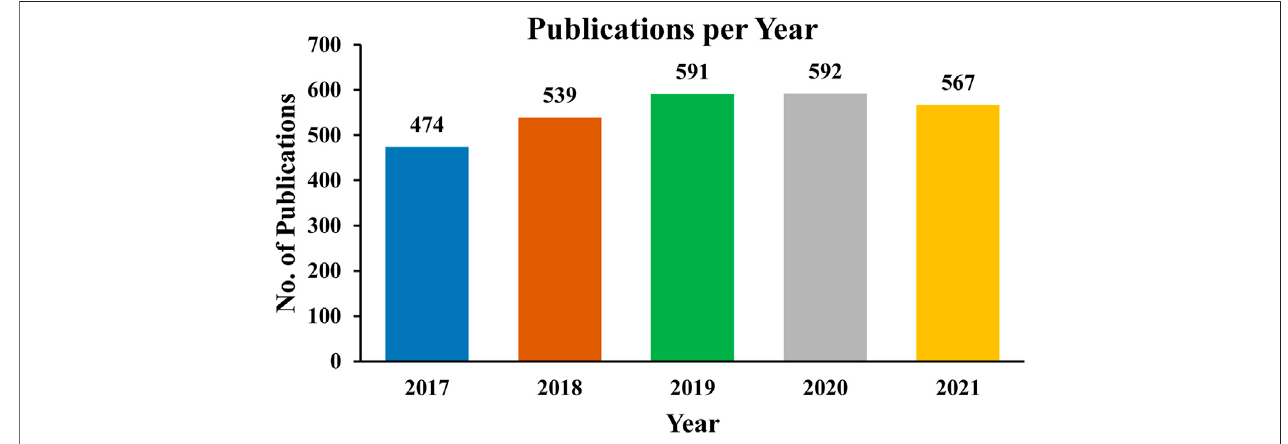
FIGURE 2 | Number of publications per year related to the theoretical studies on nonlinear optical materials: Data obtained by using keywords “ Nonlinear optical, Theoretical ” from Scopus as of November 2021.